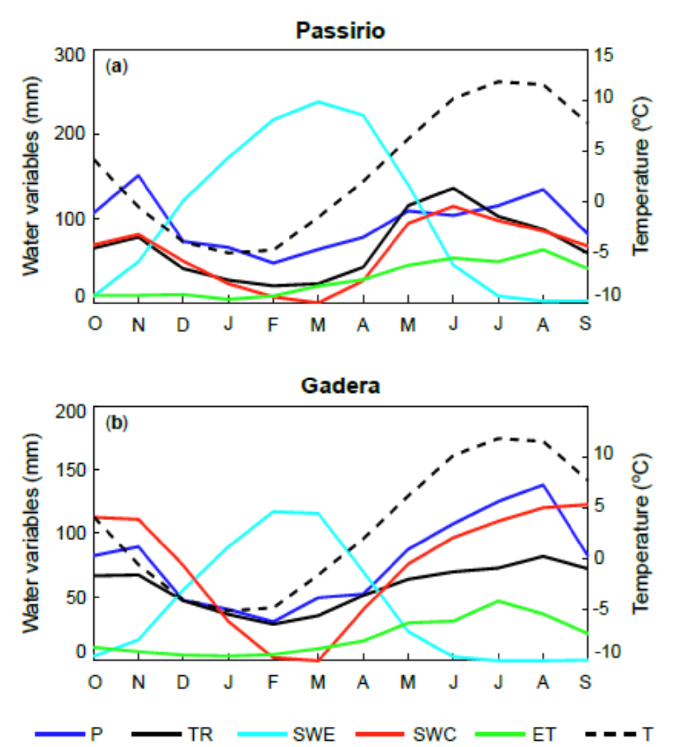
Figure 3. Mean monthly hydrological variables (left vertical axis) and temperature (right vertical axis) ( a ) the Passirio catchment; and ( b ) the Gadera catchment, over the period 2002–2018. Mean precipitation (P) and temperature (T) refer to observed values; snow water equivalent (SWE), evapotranspiration (ET), subsurface water content (SWC) and total runo ff (TR) refer to simulated values. The simulated SWC drawn has been reduced by the lowest monthly value to show only the active range. Note the di ff erence in the left vertical axes between the two case studies, as well as the di ff erence in the left and right vertical axes for each case